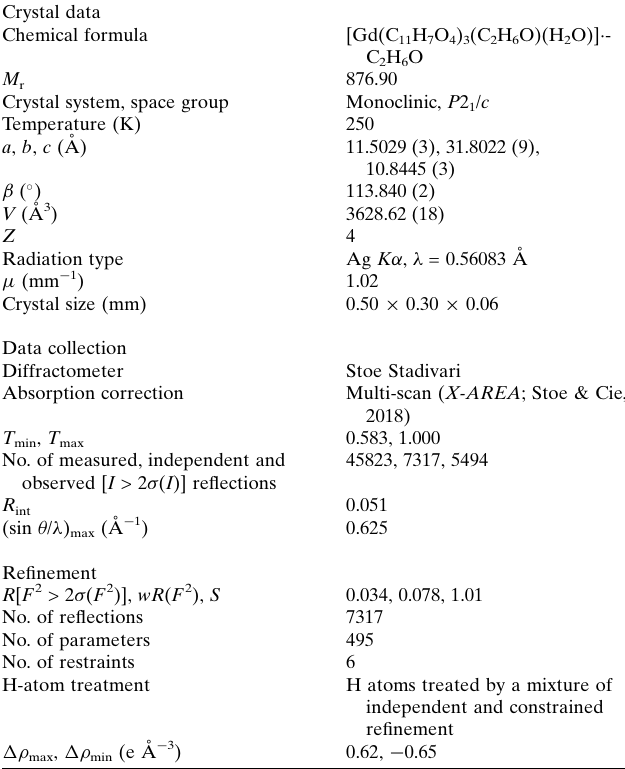
Table 2 Experimental details. Crystal data Chemical